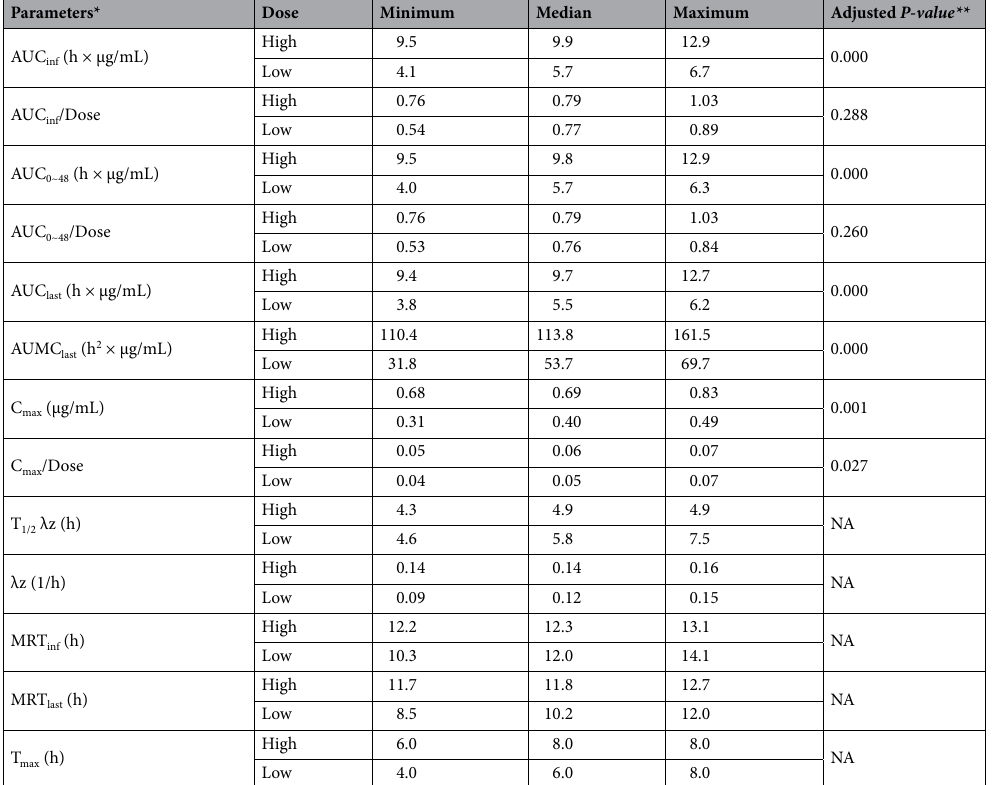
Table 3. The plasma pharmacokinetics of ciprofloxacin in calves administered enrofloxacin subcutaneously (low dose 7.5 mg/kg, high dose 12.5 mg/kg body weight, 14 animals in each healthy and BRD combined group) computed by a non-compartmental model (i.e., statistical moments) analysis. * PK-parameters area under the curve from the time of dosing extrapolated to infinity (AUC inf ), area under the curve from the time of dosing to the last sampling time point (AUC 0~48 ), area under the curve from the time of dosing to the last measurable positive concentration (AUC last ), area under the first moment curve from dosing to the last measurable concentration (AUMC last ), maximum observed concentration (C max ), mean residence time from the time of dosing to the last measurable concentration (MRT last ), time to the maximum concentration (T max ), and terminal half-life (T 1/2 λz), elimination rate (λz). NA not applicable, the PK linearity does not break in the dose range of 7.5–12.5 mg/kg. **Mann–Whitney test was used to compare the high and low dose